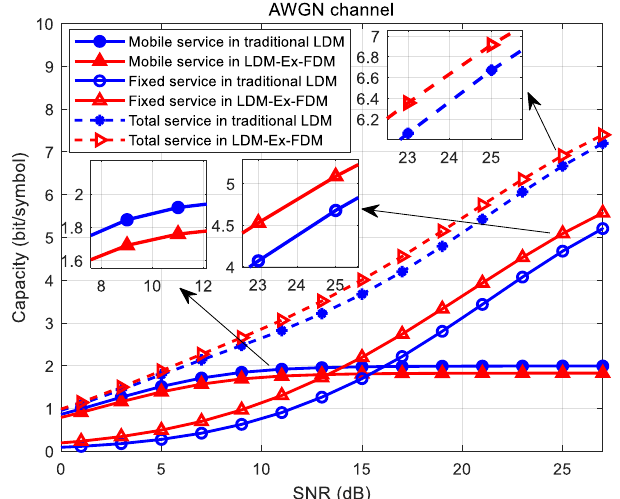
Figure 9. Capacities of mobile service and fixed service in Advanced Television System Committee (ATSC) 3.0 system with and without LDM-Ex-FDM scheme over the additive white Gaussian noise (AWGN) channel, where the parameter of ATSC 3.0 system was set to ∆ = 10 dB, the CL constellation was set to QPSK, the EL constellation was set to NU − 64QAM, and the puncturing rate of the LDM-Ex-FDM scheme was set to